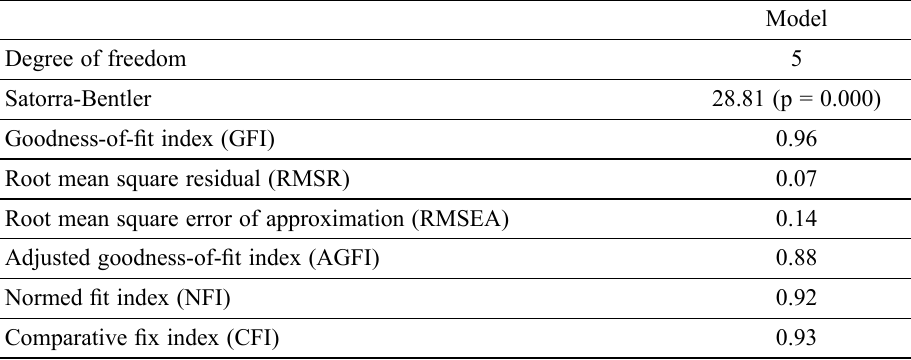
Table 2. Goodness-of-fit measures model